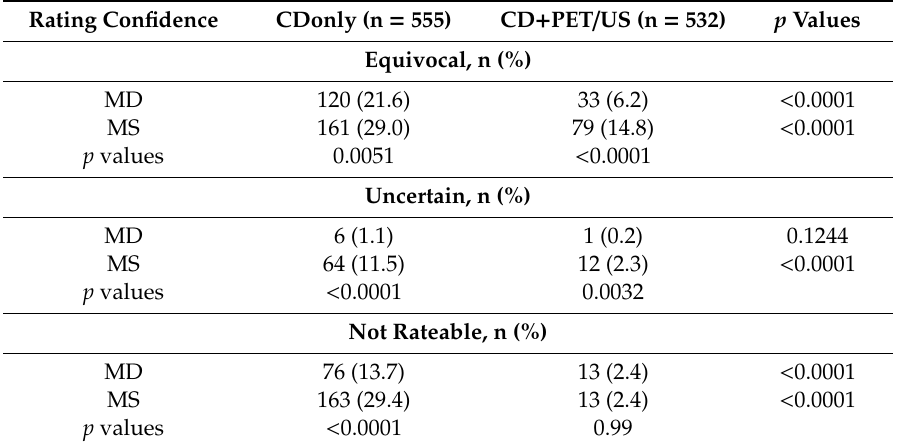
Figure 2. Illustration of the relative rating shifts in the observers’ confidence in functional assessment of thyroid nodules (TN) between conventional diagnostics (CDonly) and CD+I-124-PET/US fusion